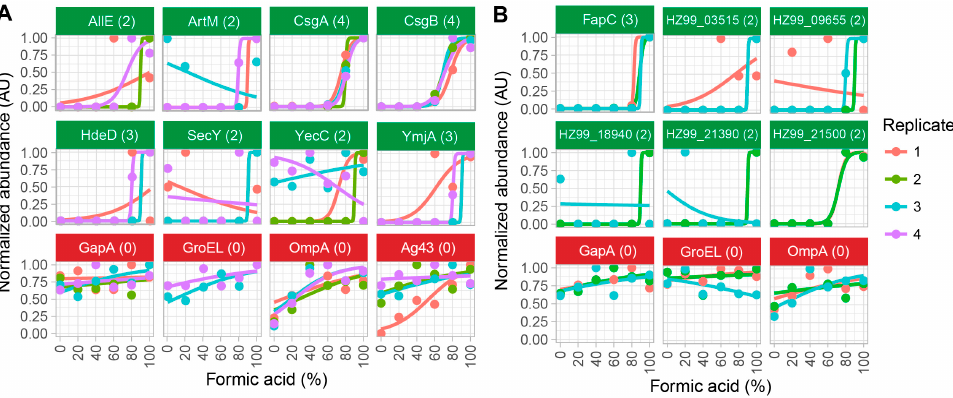
Figure 2. The identification of functional amyloid candidates in cell lysates of ( A ) Escherichia coli SM2258 and ( B ) Pseudomonas sp. UK4. Proteins with amyloid-specific abundance signatures in at least two biological replicates are shown with green titles. Negative controls are shown in red titles, which include the household proteins, Glyceraldehyde-3-phosphate dehydrogenase A (GapA) and 60 kDa chaperonin (GroEL); and β -barrel outer membrane proteins, like outer membrane protein A (OmpA) and antigen 43 (Ag43). The numbers in the parentheses indicate the number of biological replicates in which the proteins were classified as amyloid candidates based on the fitting parameters. Notice that some data points and curves are hidden as they overlap, and some proteins were not observed in all replicates.